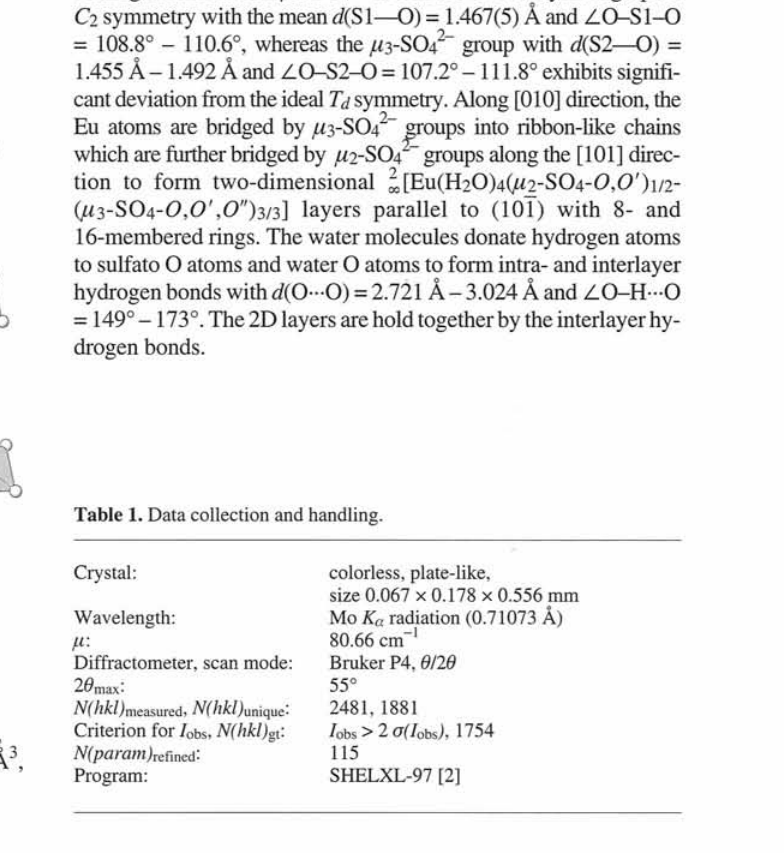
Table 1. Data collection and handling.